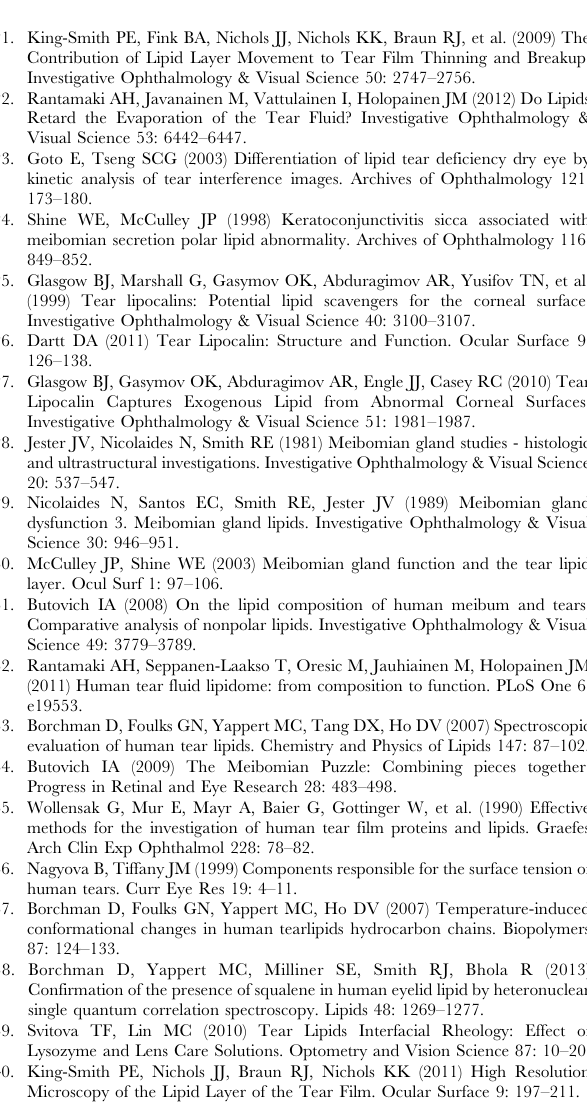
Figure S1 Density profiles of polar lipids at APPL= 68 A˚ 2 . The data are averaged over the simulation time from 0.2 m s to 1.2 m s. Profiles of headgroups and both sn-1 and sn-2 chains (‘tail